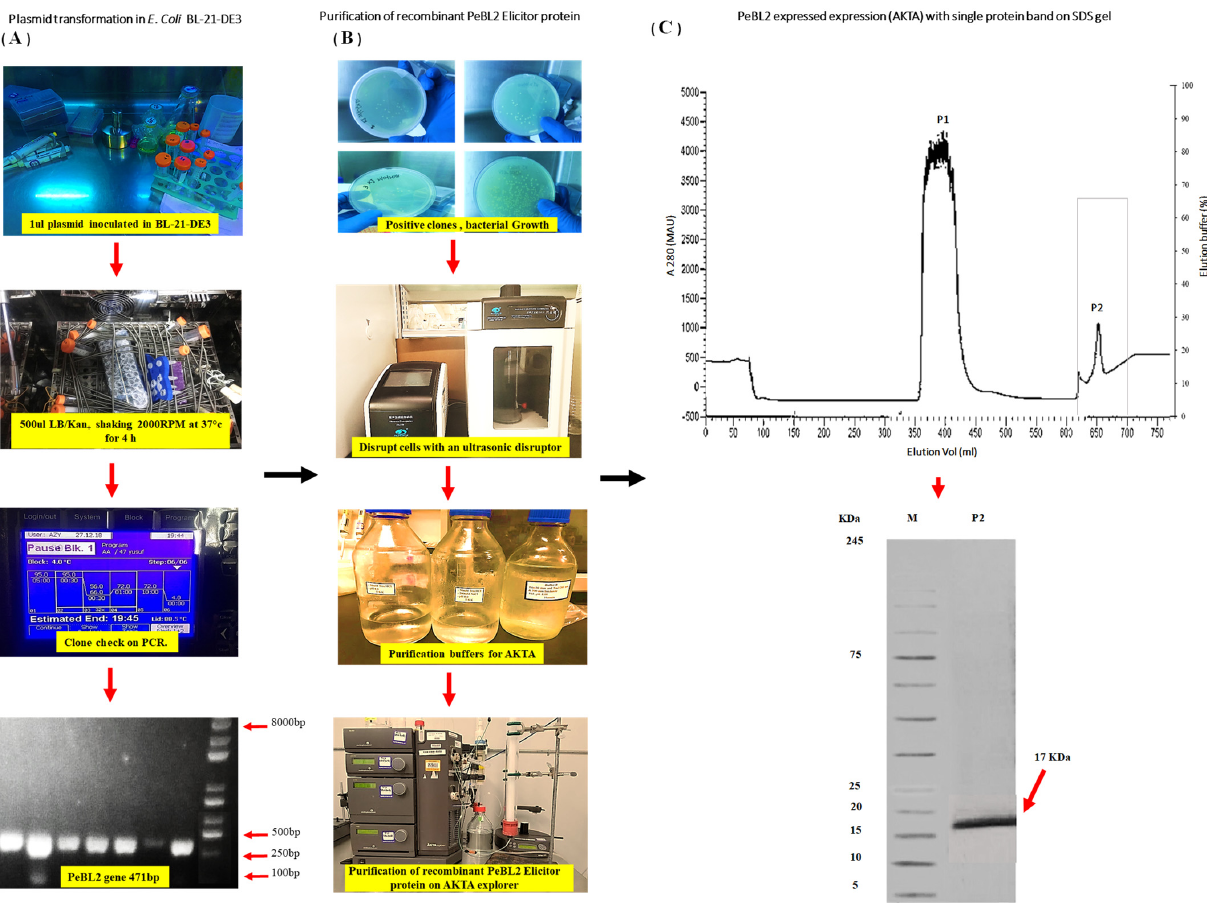
Figure 1. PeBL2, transformation and recombinant protein purification. ( A , B ) Evaluation of PeBL2 protein by using the Äkta explorer, His-Trap HP column used for the purification of total E. coli proteins. An elution buffer—25 mM Tris, 200 mM NaCl, 500 mM imidazole, and pH 8.0—was used to elute peak P2, which comprised recombinant PeBL2 with a flow rate of 5 mL/min. A HiTrap desalting column was used to load P2. ( C ) The purified and desalted PeBL2 protein formed a single band of the molecular mass of 17 kDa on Tricine SDS-PAGE. Lane M: protein molecular mass marker; lane P2: peak P2.